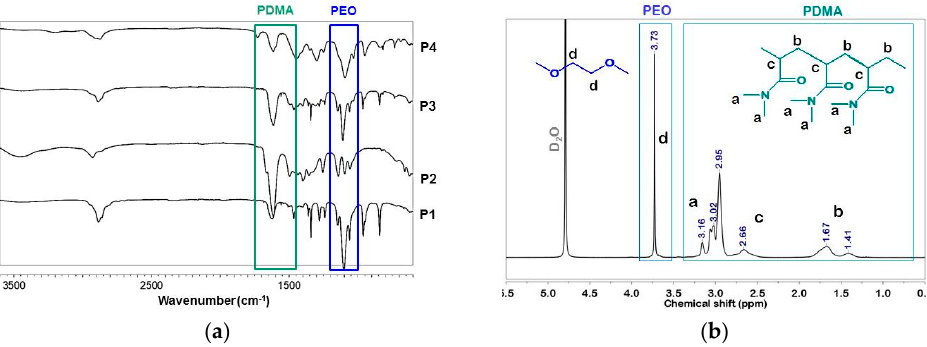
Figure 3. ( a ) Overlaid ATRFTIR spectra of copolymers P1-P4; and ( b ) 1 H NMR spectrum of P1 (600 MHz; solvent D 2 O).